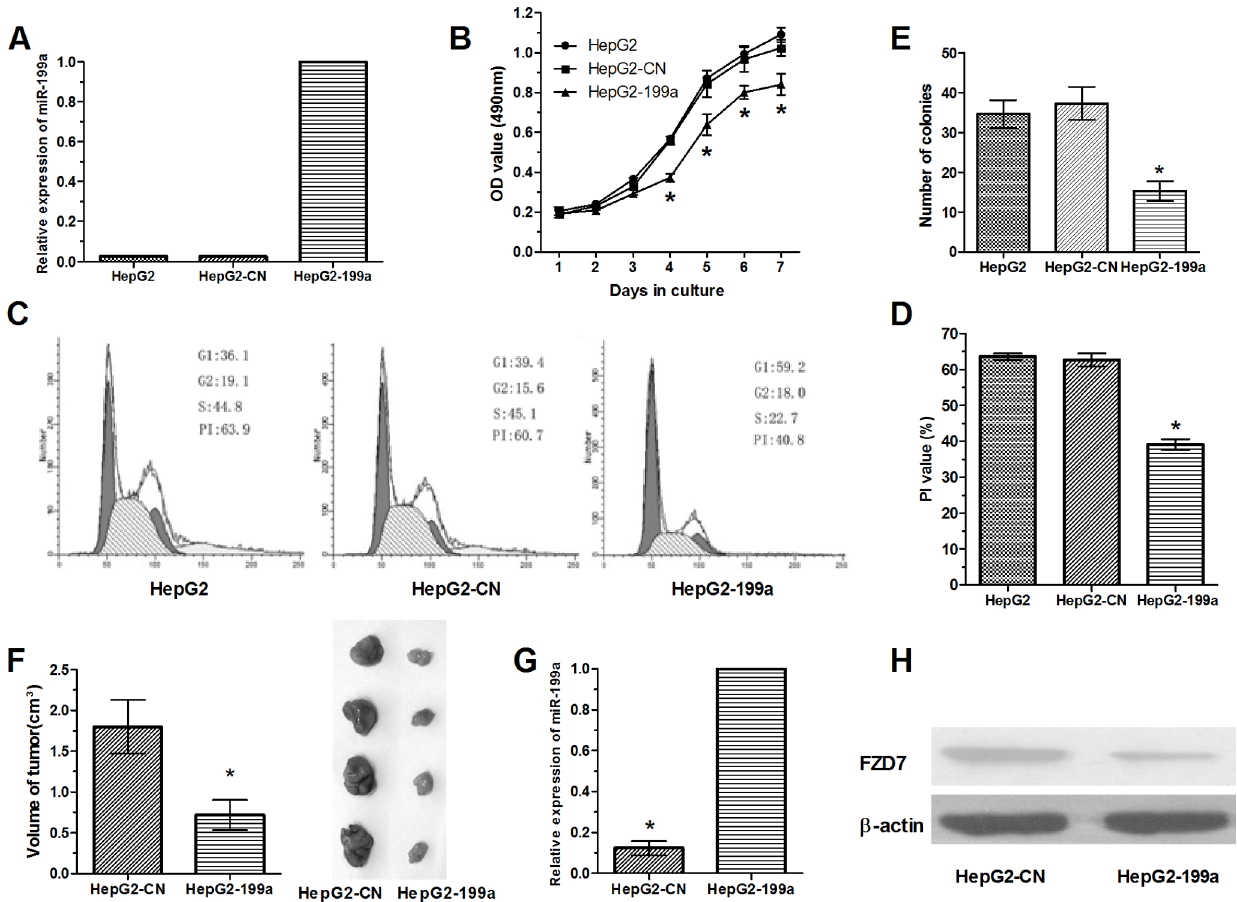
Figure 3. Over-expression of miR-199a represses growth and tumorigenicity invitro and invivo . (A) qRT-PCR analysis confirmed that miR- 199a expression was significantly up-regulated in HepG2-199a cells compared with matched controls. U6 snRNA was used as the internal control. (B) The growth curves are plotted based on the MTT assay results. The value shown is the mean of three experiments. *Statistical significance. (C) Cell cycle distribution of HepG2, HepG2-CN, and HepG2-199a cells by flow cytometry. (D) The proliferation index (PI) of HepG2, HepG2-CN, and HepG2- 199a cells, as determined by flow cytometry. The PI values that are shown are the mean of three repetitions and are expressed as the mean 6 SD. (E) Colony numbers of HepG2-CN and HepG2-199a cells in soft agar. Each soft agar assay was performed in triplicate, and the results are expressed as the mean number of colonies 6 SD. (F) Tumor size of HepG2-CN and HepG2-199a cells in nude mice. (G) MiR-199a expression in whole tumor tissue extracts by qRT-PCR analysis. (H) FZD7 expression in whole tumor tissue extracts by Western blot